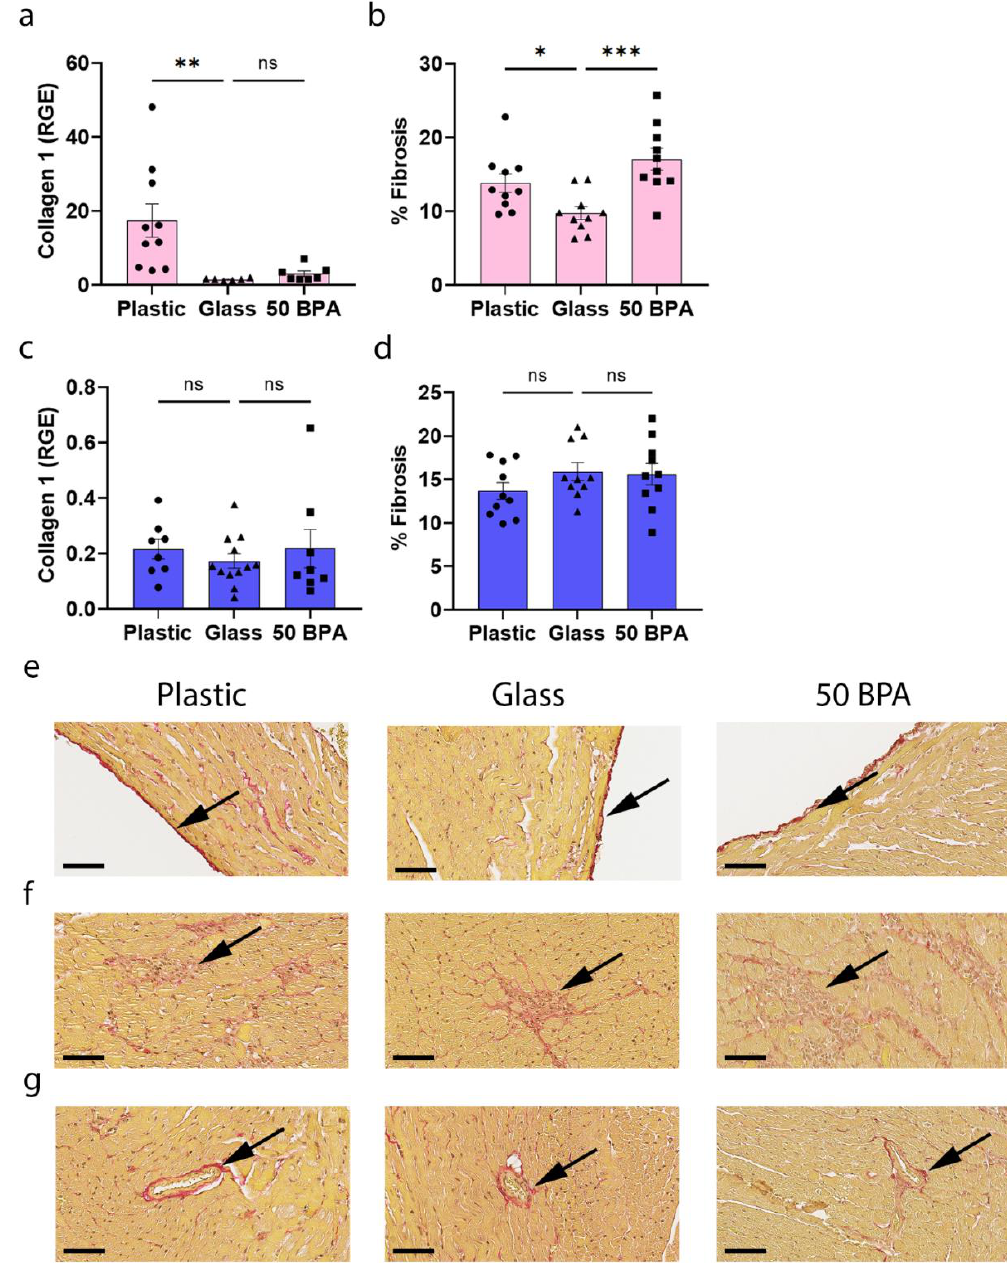
Figure 10. Plastic caging increases collagen gene expression and fibrosis in the heart of females, but not male mice during myocarditis. ( a , b ) Female (pink) and ( c , d ) male (blue) BALB/c mice were given normal drinking water (drinking water that did not contain BPA) for 2 weeks and housed either in glass cages/water bottles (glass) or plastic cages/water bottles (plastic) with soy-free food and bedding. BALB/c mice housed in glass caging with soy-free food and bedding were given either normal drinking water (drinking water that did not contain BPA) (0 BPA/glass) for 2 weeks or 250 µ g BPA/L water (50 BPA). Mice were injected i.p. with 10 3 PFU of CVB3 i.p. on day 0 and harvested at day 10 pi. ( a , c ) Collagen 1 levels in the heart were measured using qRT-PCR to determine relative gene expression (RGE) of collagen I compared to the housekeeping gene Hprt. ( b , d ) Fibrosis was assessed as the % fibrosis compared to the total size of the heart section using Sirius Red-stained sections and a microscope eyepiece grid. Data shown as scatter plot and mean +/ − SEM using one-way ANOVA with Holm –Šídák’s multiple comparisons test with 8 – 12 mice/group (* p < 0.05), (** p < 0.01), (*** p < 0.001). Representative images of fibrosis detected with Sirius Red (arrow) shown in the ( e ) pericardium, ( f ) myocardium or ( g ) vessels (magnification 400×, scale bar 60 μ m).